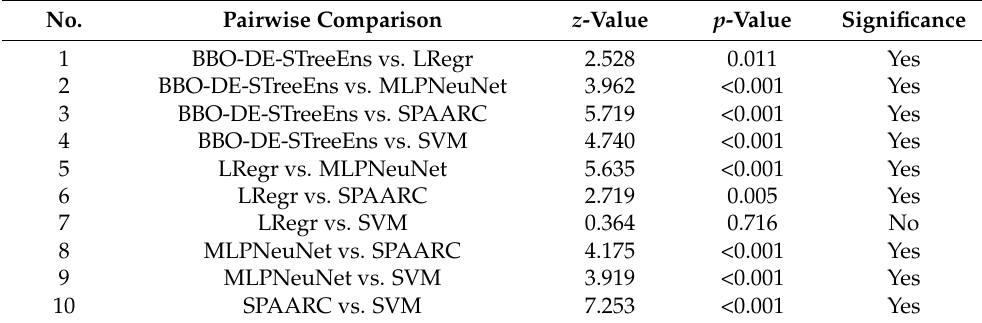
Table 3. Statistical tests of the proposed BBO-DE-STreeEns model and the other models.